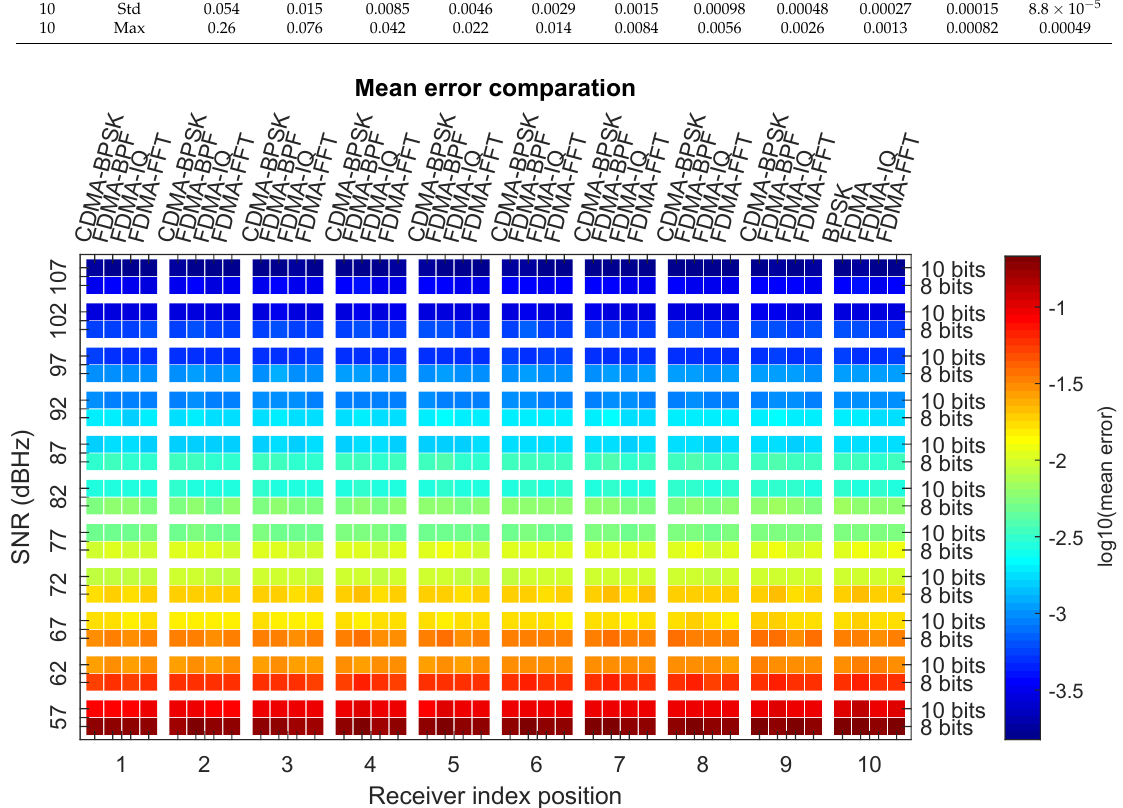
Figure 13. Comparison of the average error in the calculation of the impact point as a function of the SNR, the position of the receiver, technique used, and signal